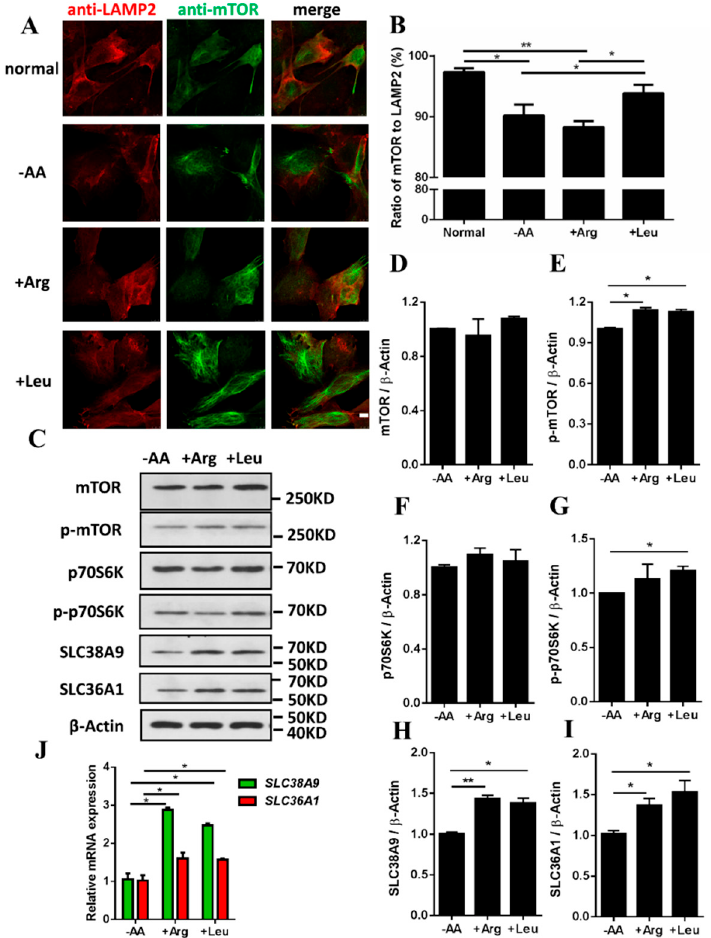
Figure 1. Effects of Arg and Leu on the location of mTOR on LAMP2-positive lysosomal clusters, activation of mTORC1 and expression of SLC38A9 and SLC36A1 in C2C12 cells. ( A ) C2C12 cells were pretreated without serum for 15 h and without amino acids for 3 h then cultured for 10 min in a special medium (Supplemental Table S1) including the no amino acids group ( − AA), the only Arg group (+Arg), and the only Leu group (+Leu). Cells were stained with anti-mTOR (A2445, Abclonal Technology, Wuhan, China) or anti-LAMP2. Scale bar: 10µM. ( B ) Ratio of mTOR to LAMP2 (%). To assess mTOR translocation, the numbers of mTOR and LAMP2-positive spots per cell were calculated using IPP6.0 and Image J software. ( C ) Immunoblotting analysis of protein samples from ( A ) with anti-mTOR, anti-phospho-mTOR, anti-S6K, anti-phospho-S6K, anti-SLC38A9, anti-SLC36A1, or anti- β -Actin antibody. ( D ) Densitometric analysis of the immunodetection of mTOR relative to β -Actin loading control. ( E ) Densitometric analysis of the immunodetection of phospho-mTOR relative to β -Actin loading control. ( F ) Densitometric analysis of the immunodetection of p70S6K relative to β -Actin loading control. ( G ) Densitometric analysis of the immunodetection of phospho-p70S6K relative to β -Actin loading control. ( H ) Densitometric analysis of the immunodetection of SLC38A9 relative to β -Actin loading control. ( I ) Densitometric analysis of the immunodetection of SLC36A1 relative to β -Actin loading control. ( J ) The mRNA levels of SLC38A9 and SLC36A1 were analyzed by qRT-PCR. Values are the mean ± SEM; n = 3; * p < 0.05; ** p < 0.01.